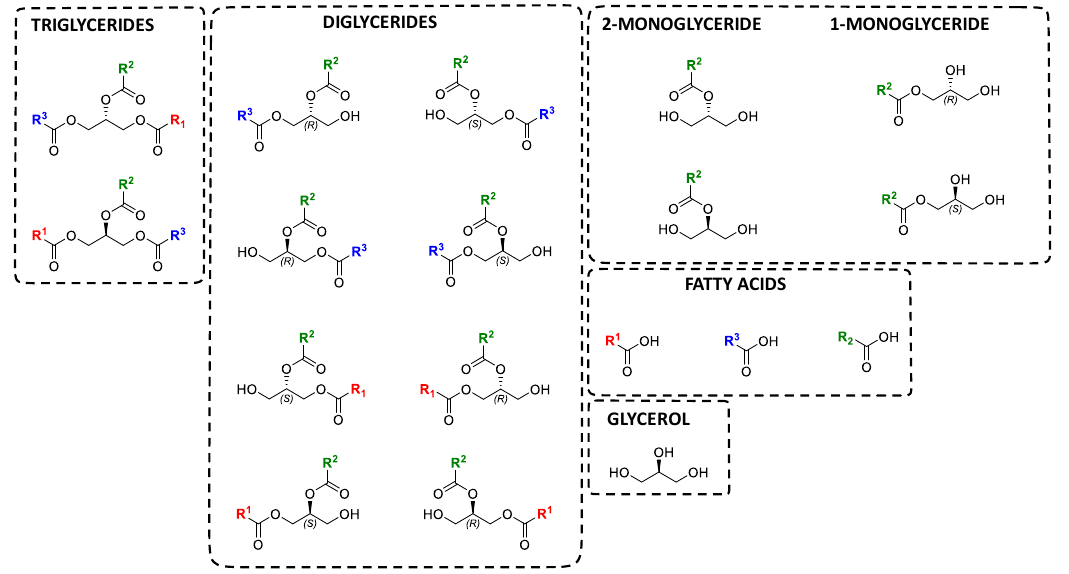
Figure 10. Di ff erent components of a reaction, including the intermediate products, when an oil is hydrolyzed.